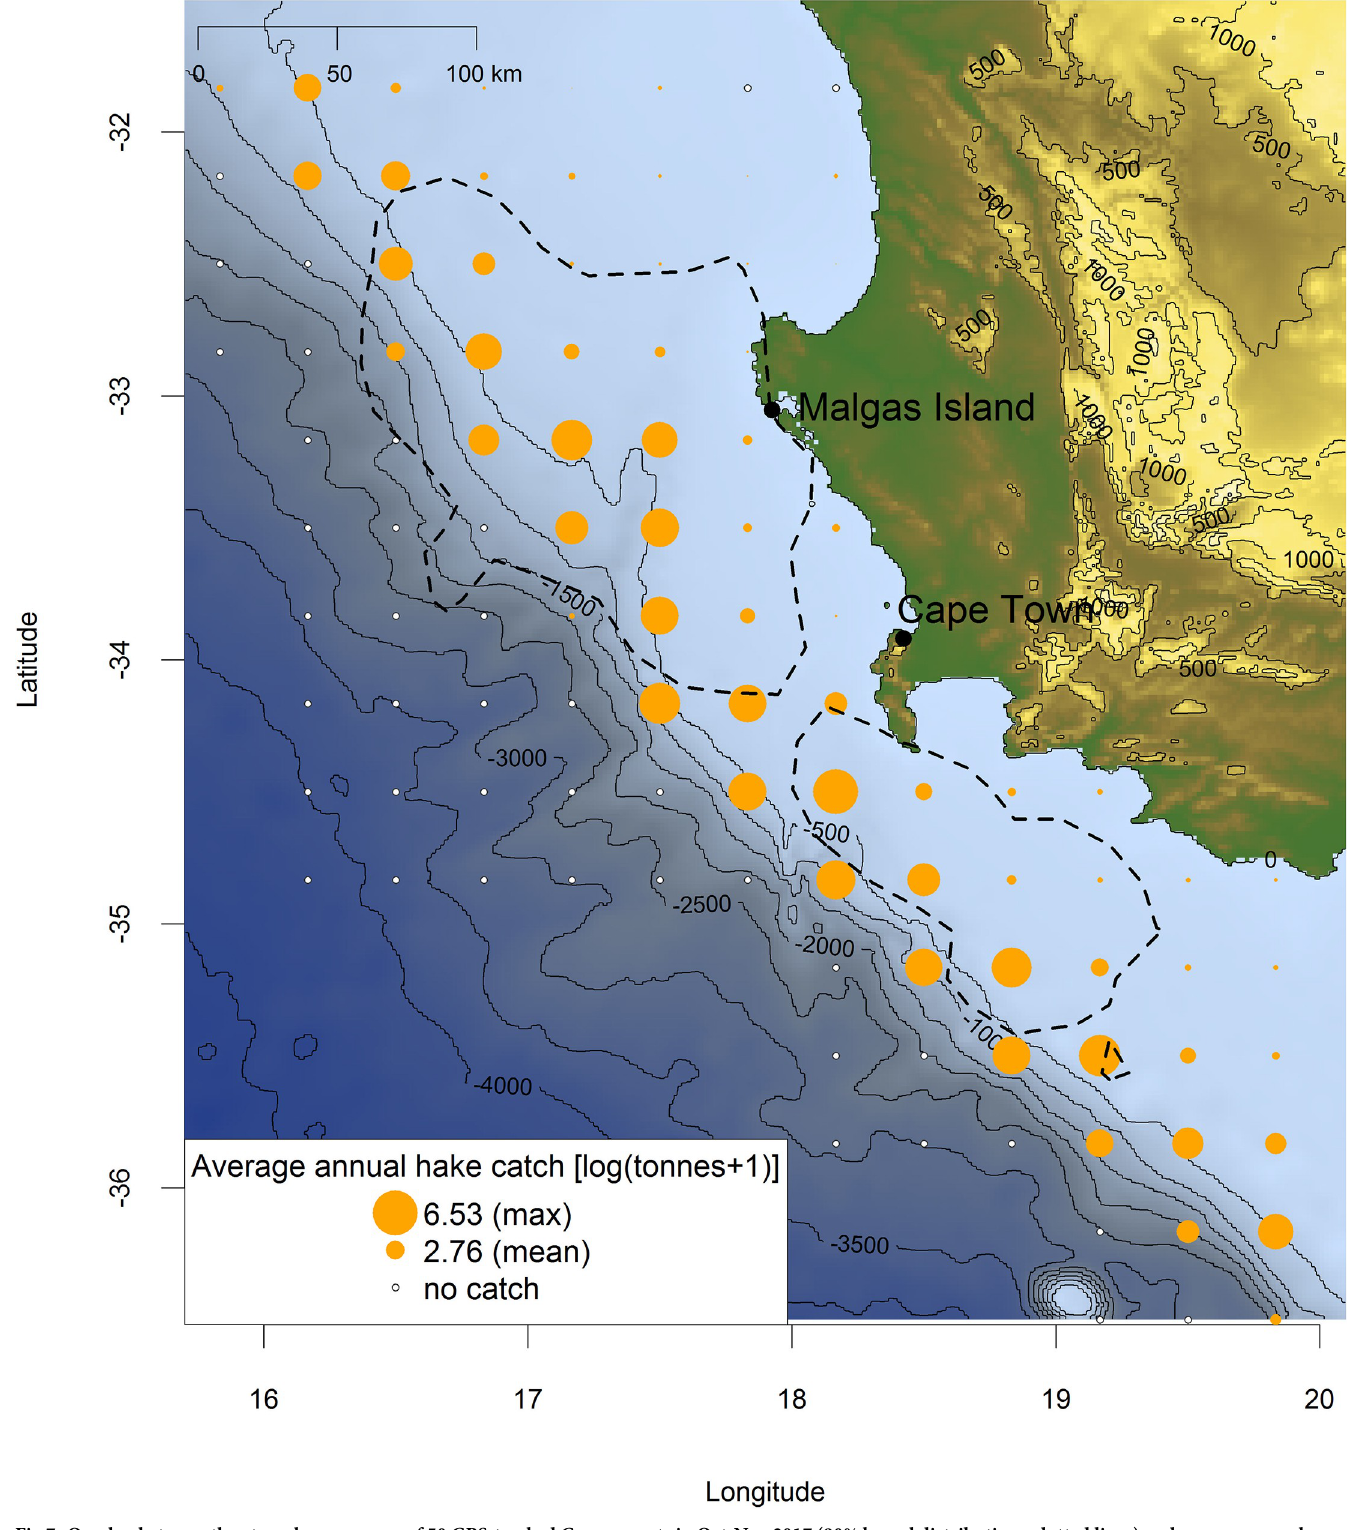
Fig 7. Overlap between the at-sea home-ranges of 50 GPS-tracked Cape gannets in Oct-Nov 2017 (90% kernel distributions, dotted lines) and average annual hake catch by trawlers in 2008–2015 (log tonnes+1; orange dots). The size of orange dots increases with catch value from 0.17 to 6.53. White dots represent no catch in the fishing area. Blue shades indicate bathymetry (R package